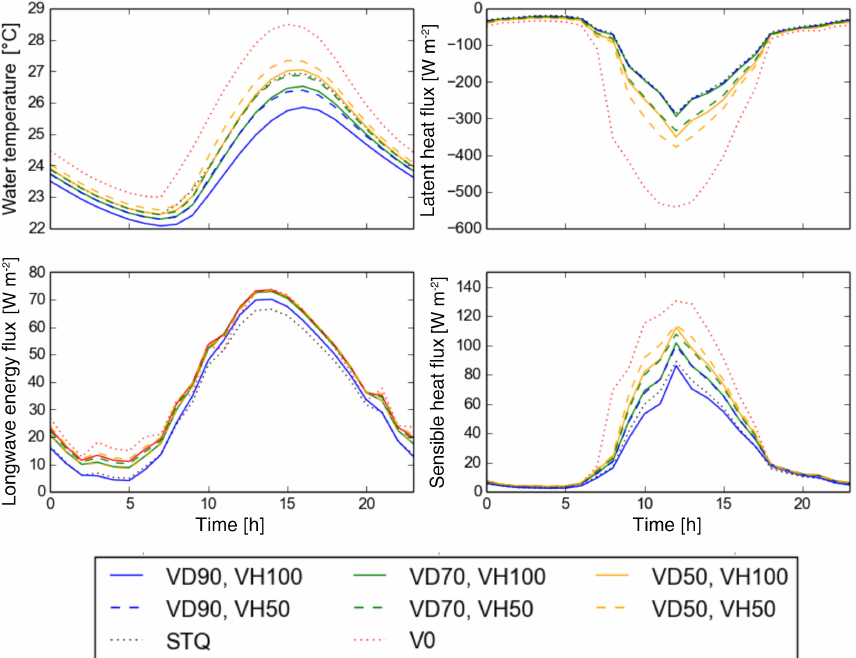
Figure 7. The effect of the vegetation scenarios of maximum vegetation height (VH100) and 50% vegetation height (VH50), natural dense vegetation (VD90), natural light vegetation (VD70), sparse vegetation (VD50), V0 (no vegetation) and STQ (actual vegetation) on the diurnal amplitude of water temperature and the air-temperature-dependent energy fluxes longwave radiation, sensible and latent heat fluxes for the 20-year return period events of the final day of the climate periods centred on 2085 for mean low flow conditions (MLF) for an upstream location (DFS